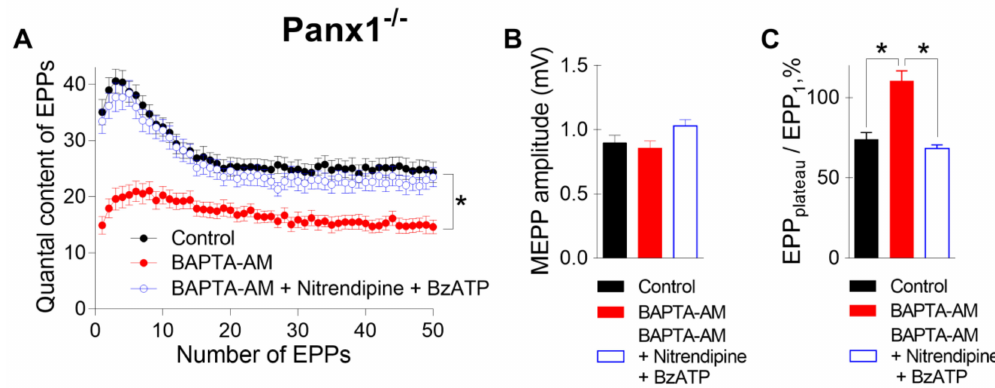
Figure 6. Blocking L-type voltage-dependent Ca 2 + channels (VDCCs) with nitrendipine (1 µ M) failed to prevent the P2X7-mediated recovery of BAPTA-induced depression of evoked neuromuscular transmission at the NMJs of Panx1 − / − mice. ( A ) Changes in the EPP quantal content in the control group (n = 24), after incubation with BAPTA-AM (50 µ M) (n = 22) and during the subsequent activation of P2X7 receptors by their agonist BzATP (30 µ M) in the presence of nitrendipine (n = 21). ( B ) MEPP amplitude in the control group, after incubation with BAPTA-AM and during the subsequent application of BzATP in the presence of nitrendipine. ( C )The ratio of the average quantal content of the last ten EPPs in the train to the quantal content of the first EPP (EPP plateau / EPP 1 ) normalized to EPP 1 (taken as 100%) in the control group, after incubation with BAPTA-AM and during the application of BzATP with nitrendipine in the presence of preloaded BAPTA. The symbols, histograms and error bars represent the mean ± SEM. * p <